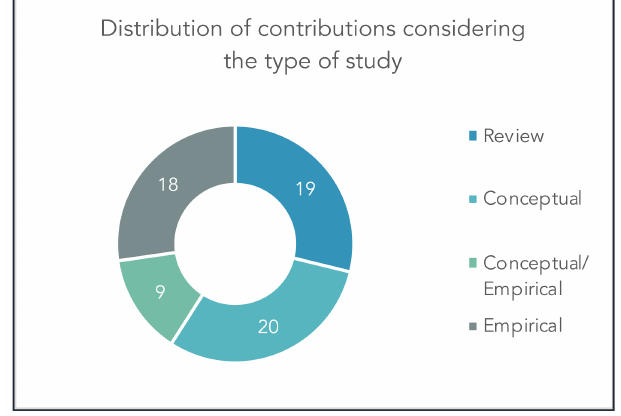
Figure 11. Distribution of the reviewed contributions according to the type of study.